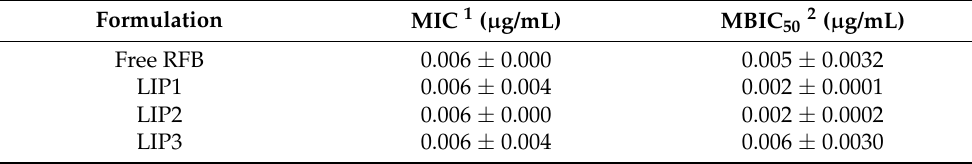
Table 3. Planktonic and biofilm MSSA susceptibility to RFB in free form or loaded in liposomes.